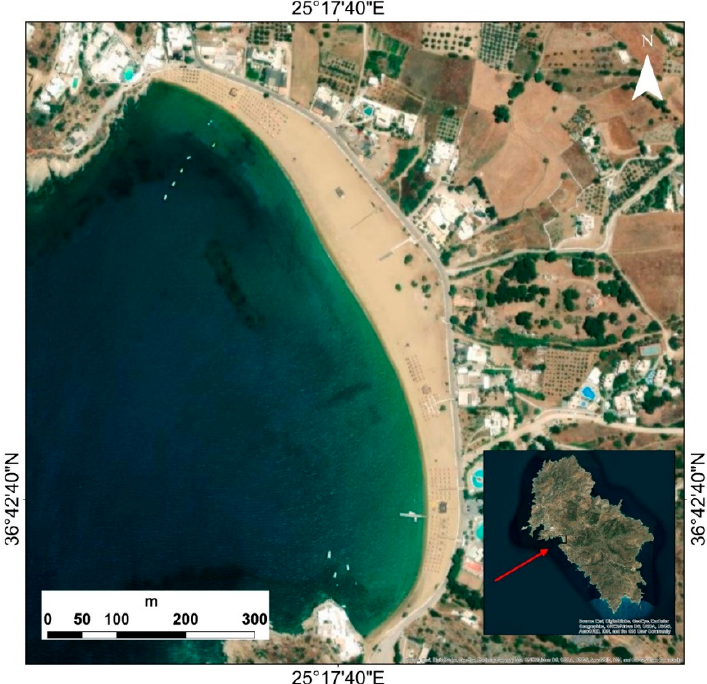
Figure 2. Mylopotas beach located in the western part of Ios. Red arrow indicates the position of the study